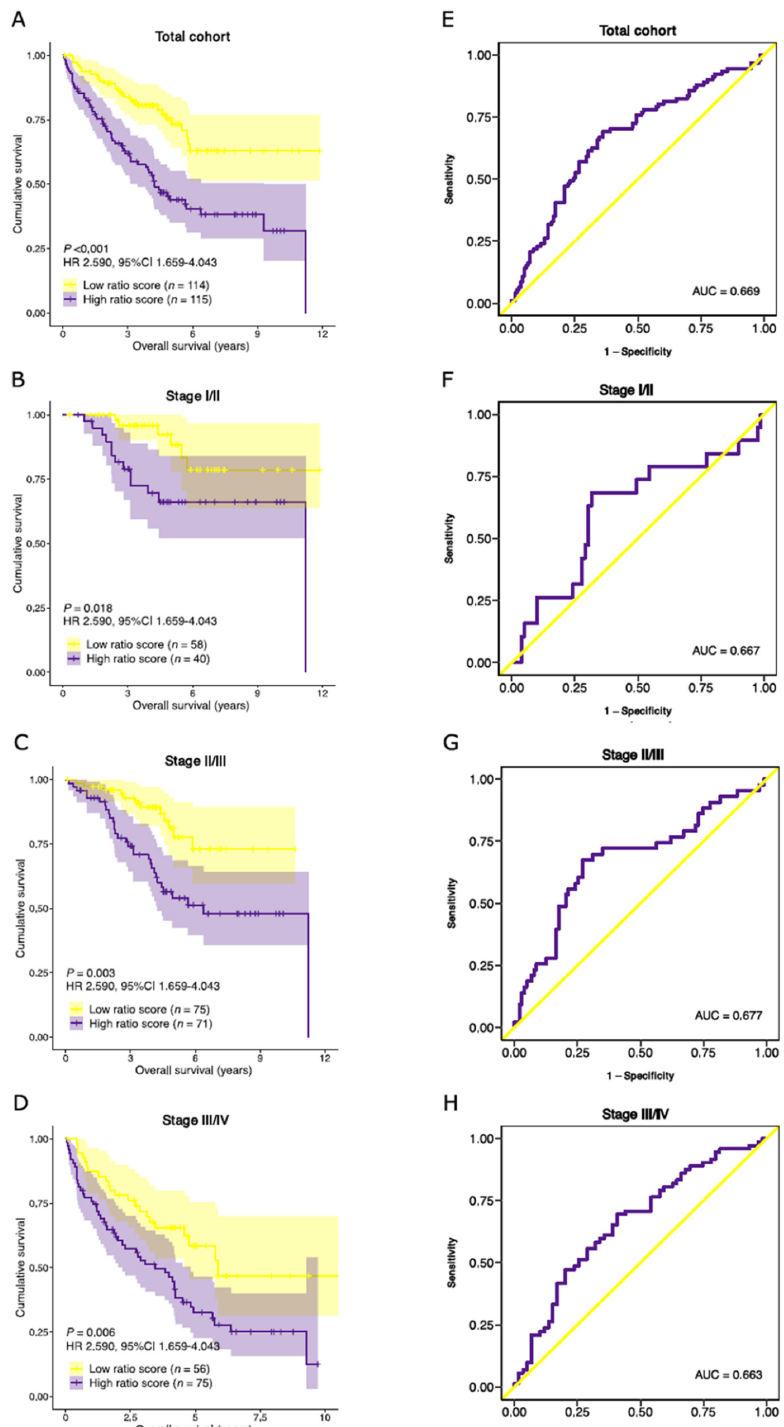
Figure 8. Validation of the prognostic performance of the stromal-epithelial signature ratio in an external cohort. Kaplan-Meier curves of the overall survival time for the stromal-epithelial ratio-risk scores in ( A ) the total cohort ( n = 229), ( B ) stage I/II ( n = 98), ( C ) stage II/III ( n = 146), and ( D ) stage III/IV ( n = 131) subpopulations. Patients with a high ratio-risk score, categorized by the 50th percentile (median) cut-off, demonstrated a shorter overall survival time. Corresponding area under the receiver operating characteristic curve (AUC) of the stromal-epithelial signature ratio for ( E ) the total cohort, ( F ) stage I/II, ( G ) stage II/III, and ( H ) stage III/IV subpopulations. HR, hazard